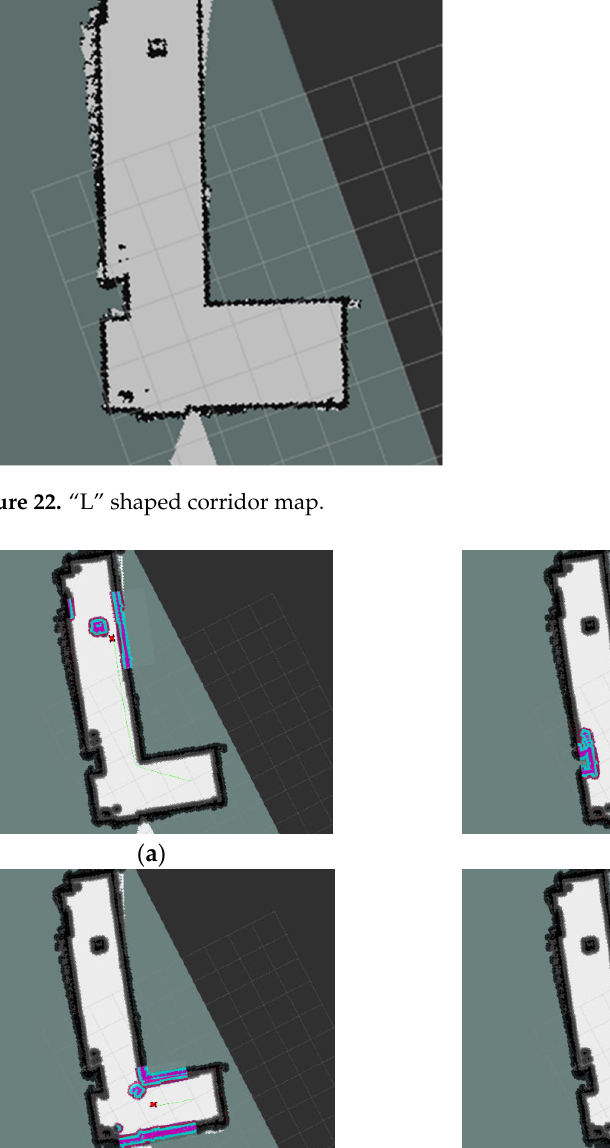
Figure 22. “ L” shaped corridor map.